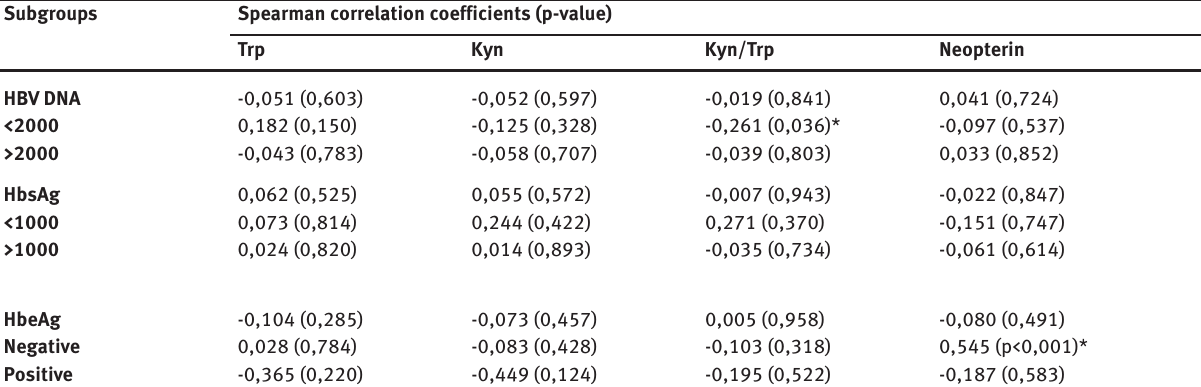
Table 3: Correlations for Trp, Kyn, Kyn/Trp, and neopterin levels in HBV patient